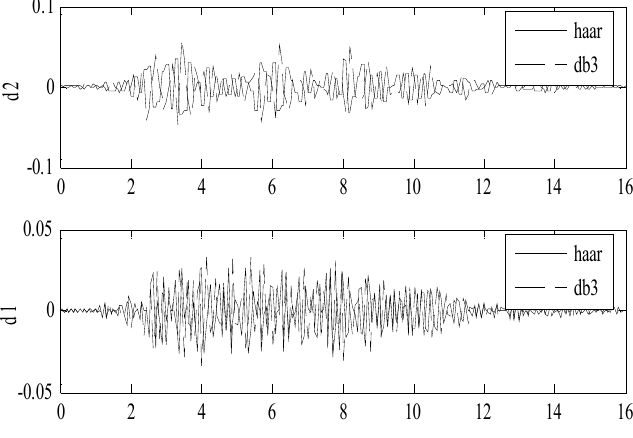
Fig. 14. Comparison of different wavelet bases in synthesis